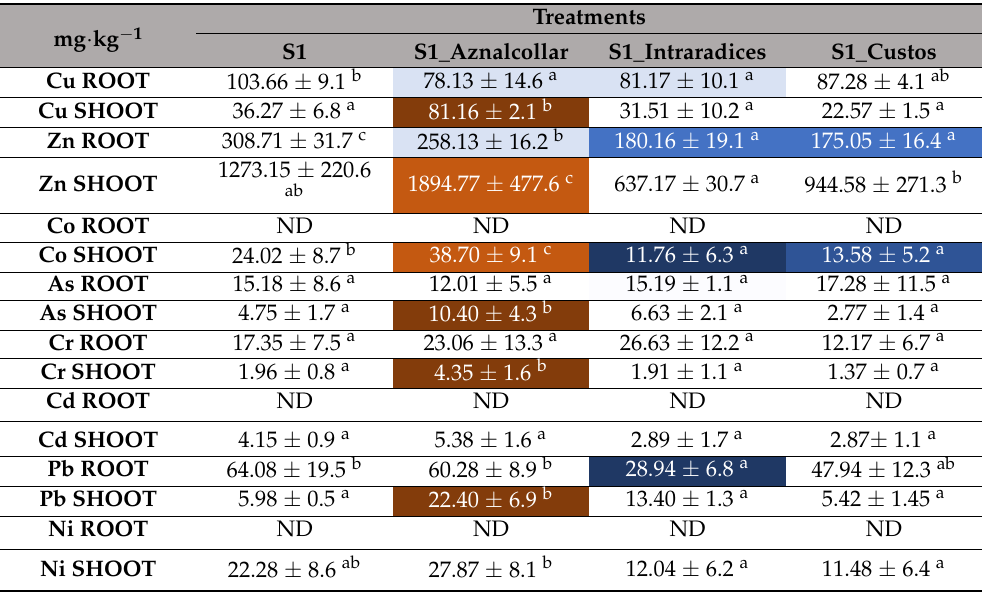
Table 3. Heavy metal concentration in roots and shoots in soil 1 (S1) and soil 2 (S2) inoculated with the three selected AMF (Aznalcollar, Intraradices, and